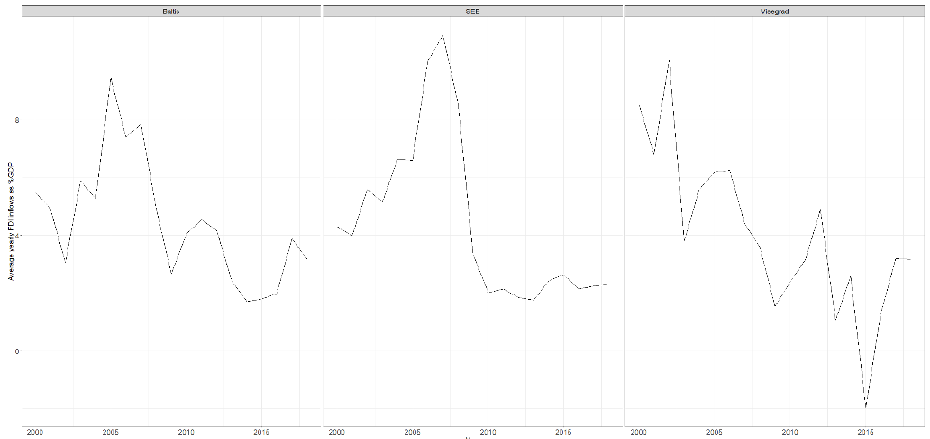
Figure 2: FDI openness in the CEEC regions